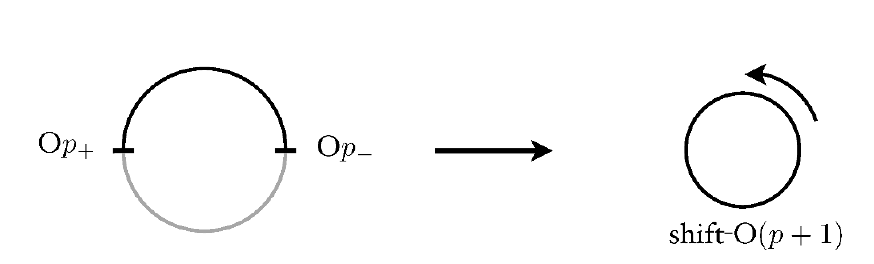
Figure 1 . A model with two O p -planes with opposite sign is turned by